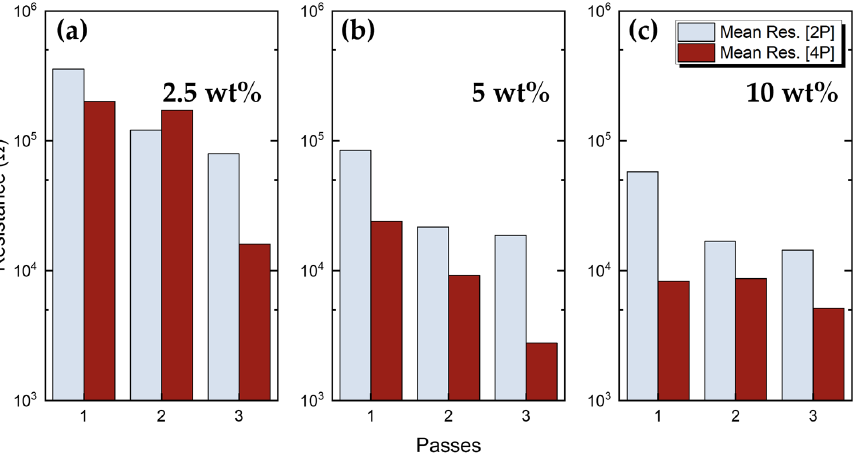
Figure 6. Two-point (2p) and four-point (4p) resistance measurements, as a function of different printing passes for: ( a ) 2.5 wt%; ( b ) 5 wt%; ( c ) 10 wt% f –rGO ink